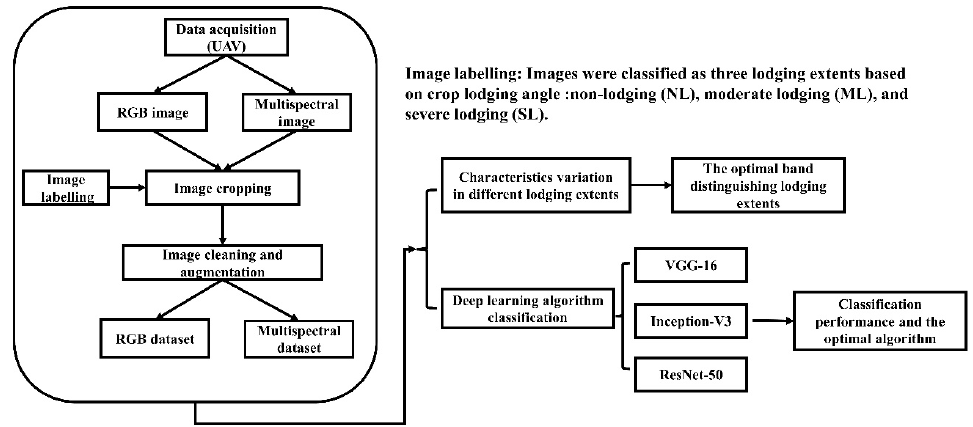
Figure 1. Flowchart of RGB and multispectral dataset acquisition and classification of different lodging extents using deep learning algorithms.